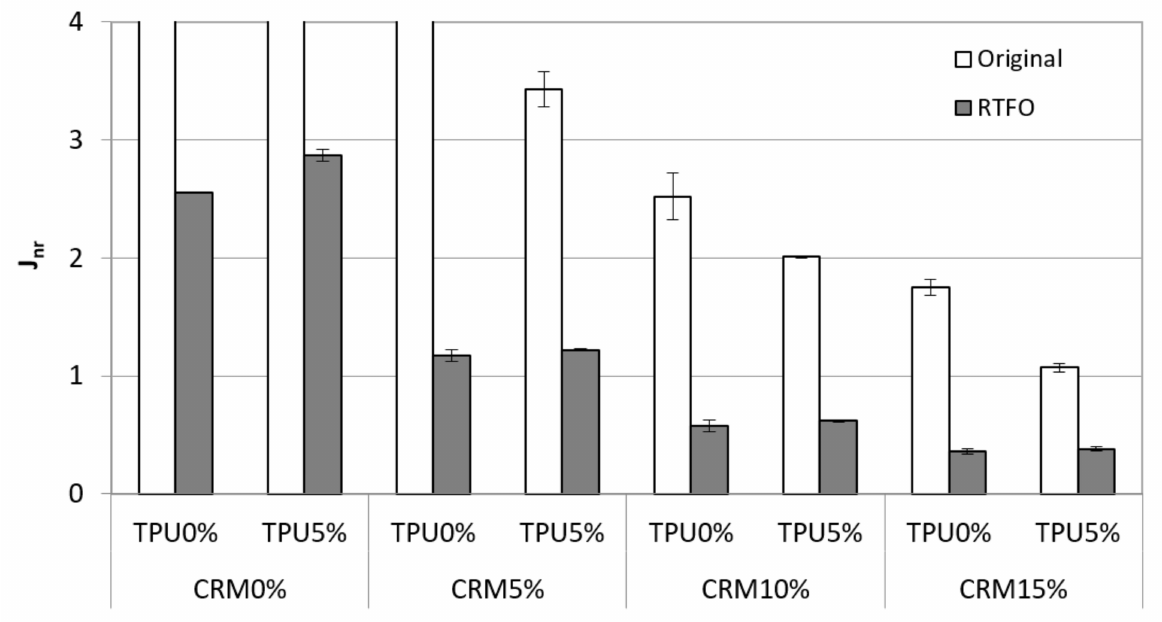
Figure 8. J nr of the CRM asphalt binders containing CRM and TPU for original and RTFO